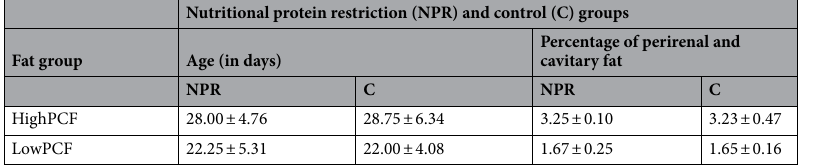
Table 1. Summary statistics (mean ± standard deviation) for the half-carcass percentage of perirenal and cavitary fat (PCF) and age (in days) for the lambs from the nutritional challenge and fat groups. C lambs which were born from control dams; NPR lambs which were born from nutritional protein restriction dams; HighPCF lambs which were assigned to the high PCF group; LowPCF lambs which were assigned to the low PCF